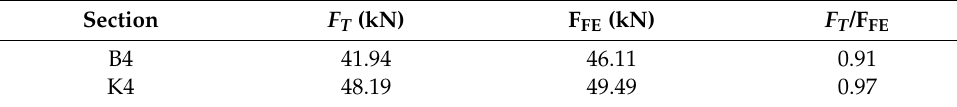
Figure 9. Load–vertical displacement curves. Table 3. Comparison of the ultimate load capacity of the CFS beams.